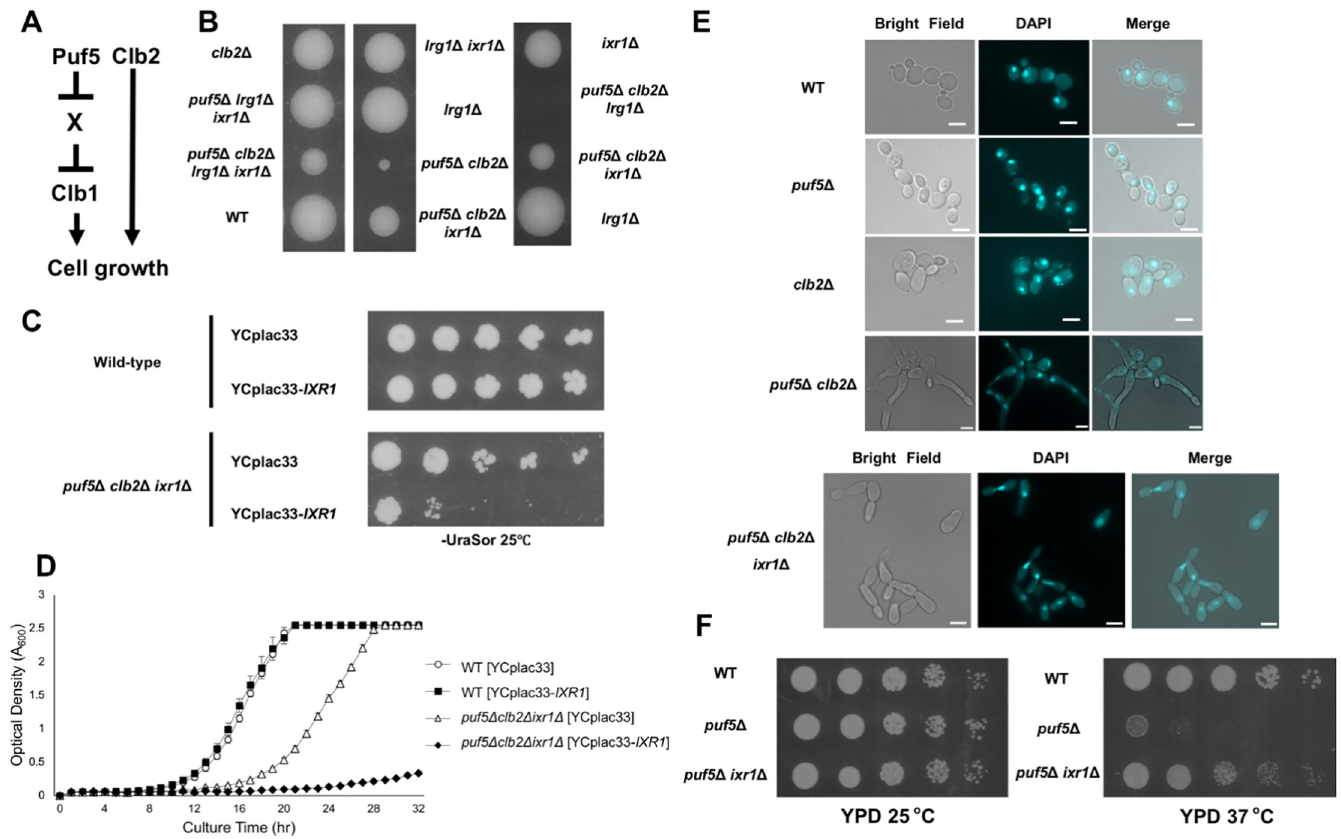
Fig 5. Deletion of IXR1 recovered the growth defect of the puf5 Δ clb2 Δ double mutant. (A) A model showing how Puf5 functions in cell growth through the CLB1 regulation. The hypothesis is presented that Puf5 negatively regulates the expression of X, and X negatively regulates CLB1 expression. (B) The tetrad analysis of the strains that are heterozygous for the alleles of PUF5 , CLB2 , IXR1 , and LRG1 . The cells were sporulated, dissected on a YPD plate, and cultured at 30˚C for 3 days. (C) The spot assay of wild-type and the puf5 Δ clb2 Δ ixr1 Δ triple mutant harboring plasmids YCplac33 or YCplac33- IXR1 . The strains were cultured in an SC-Ura medium containing 10% sorbitol at 25˚C until the exponential phase and collected. Cells were serially diluted, spotted onto an SC-Ura plate containing 10% sorbitol, and incubated for 4 days at 25˚C. (D) The growth curve of wild-type and the puf5 Δ clb2 Δ ixr1 Δ triple mutant harboring plasmids YCplac33 or YCplac33- IXR1 at 25˚C. The strains were pre-cultured in an SC-Ura medium overnight at 25˚C, then transferred into a fresh SC-Ura medium, and cultured at 25˚C for 1.5 days. The data shows the mean ± SE (n = 3) of the optical density. The white circle markers show wild-type [YCplac33], the black square markers show wild-type [YCplac33- IXR1 ], the white triangle markers show the puf5 Δ clb2 Δ ixr1 Δ [YCplac33], and the black rhombus markers show the puf5 Δ clb2 Δ ixr1 Δ [YCplac33- IXR1 ]. (E) Morphology of wild-type, the puf5 Δ mutant, the clb2 Δ mutant, the puf5 Δ clb2 Δ double mutant, and the puf5 Δ clb2 Δ ixr1 Δ triple mutant strains. Bright field (left), DAPI staining (middle), and overlayed (right) were shown. The scale bar represents 5 μ m. (F) The spot assay of wild-type, the puf5 Δ mutant, and the puf5 Δ ixr1 Δ double mutant. The strains were cultured in a YPD medium at 25˚C until the exponential phase. Cells were serially diluted, spotted onto YPD plate and incubated for 1 day at 25˚C or 37˚C.